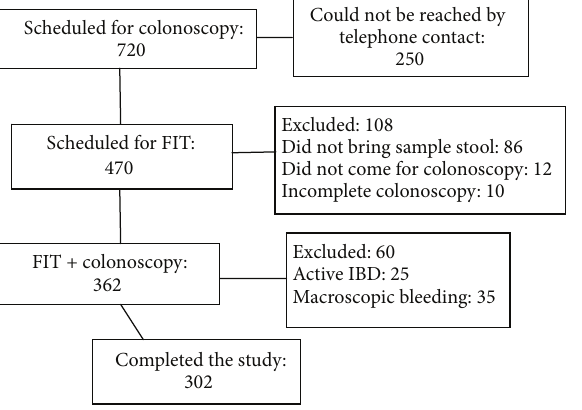
Figure 2: FIT positivity in relation to the colonoscopic